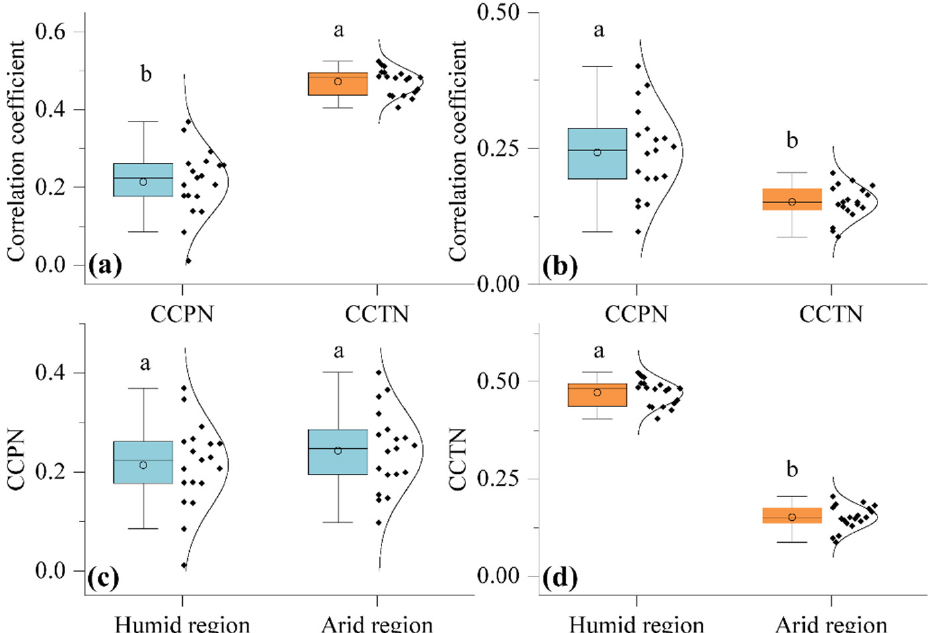
Figure 5. The effects of precipitation on the NPP and temperature on the NPP in relatively humid regions ( a ) as well as in relatively arid regions ( b ); the effects of precipitation on the NPP in relatively humid and arid regions ( c ); the effects of temperature on the NPP in relatively humid and arid re- gions ( d ) from 2001 to 2019. Note: CCPN and CCTN represent the correlation between precipitation and NPP, and the correlation between temperature and NPP, respectively.